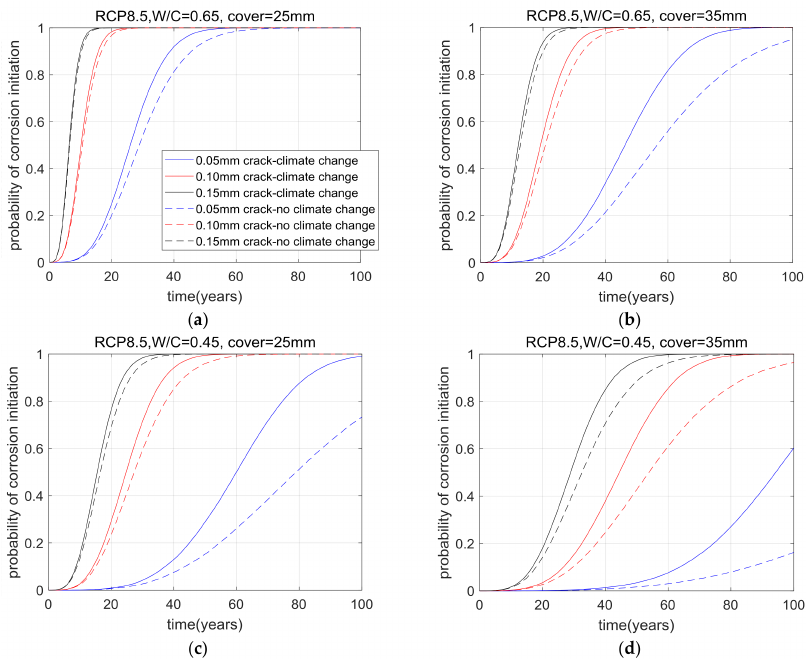
Figure 8. Probability of corrosion initiation-RCP 8.5, time slice 2000. ( a ) W/C: 0.65, Cover depth: 25 mm; ( b ) W/C: 0.65, Cover depth: 35 mm; ( c ) W/C: 0.45, Cover depth: 25 mm; ( d ) W/C: 0.45, Cover depth: 35 mm.